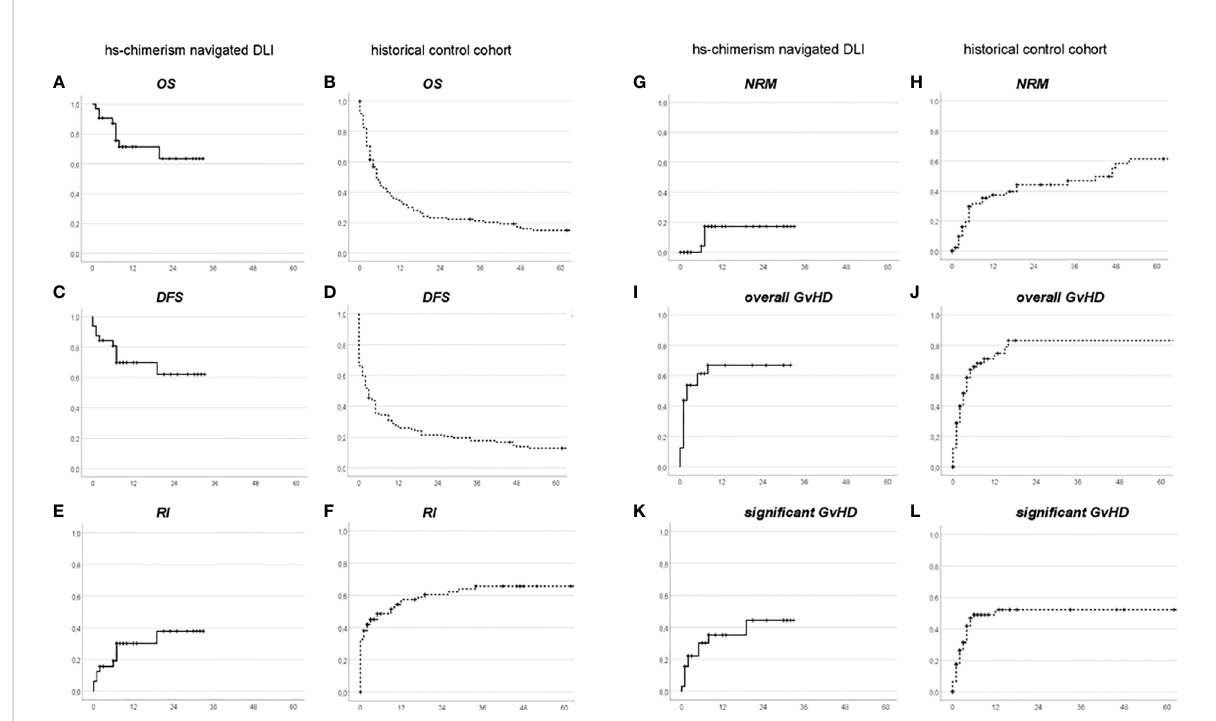
FIGURE 2 Landmark Overall Survival (A, B) , Disease-Free Survival (C, D) , Relapse Incidence (E, F) , Non-Relapse Mortality (G, H) , overall GvHD (I, J) , and signi fi cant GvHD (K, L) , from fi rst DLI, in the hs-chimerism navigated group (A, C, E, G, I, K) or the historical control group (B, D, F, H, J, L) , respectively. x-axes: months after fi rst